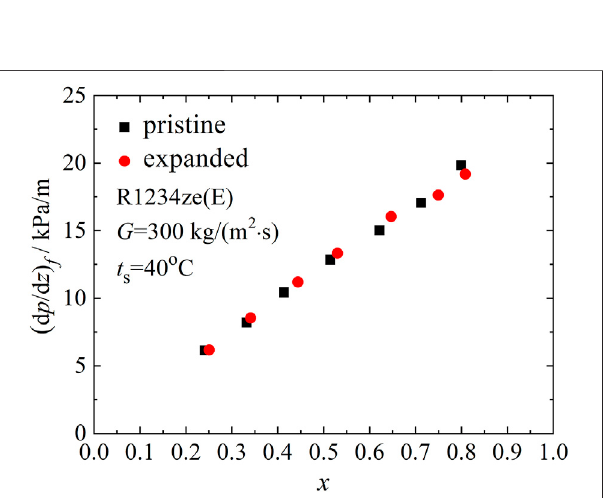
FIGURE 11 | Effect of tube expansion on friction pressure gradients at 300 kg/(m 2 ·